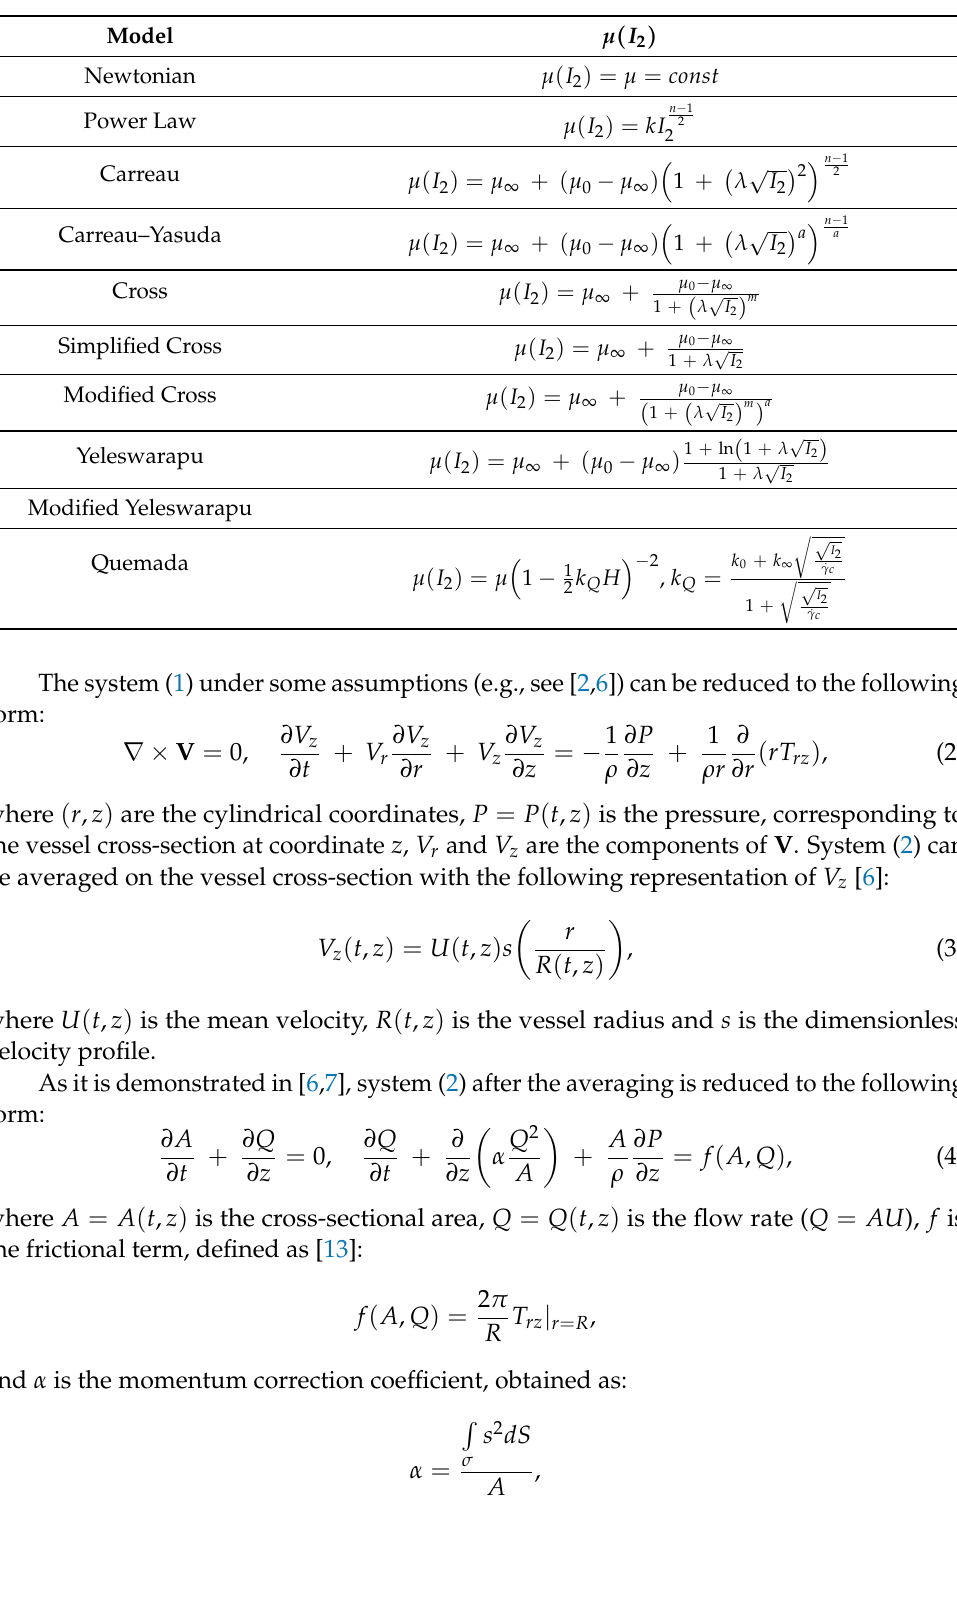
Table 1. Rheological models of blood as generalized Newtonian